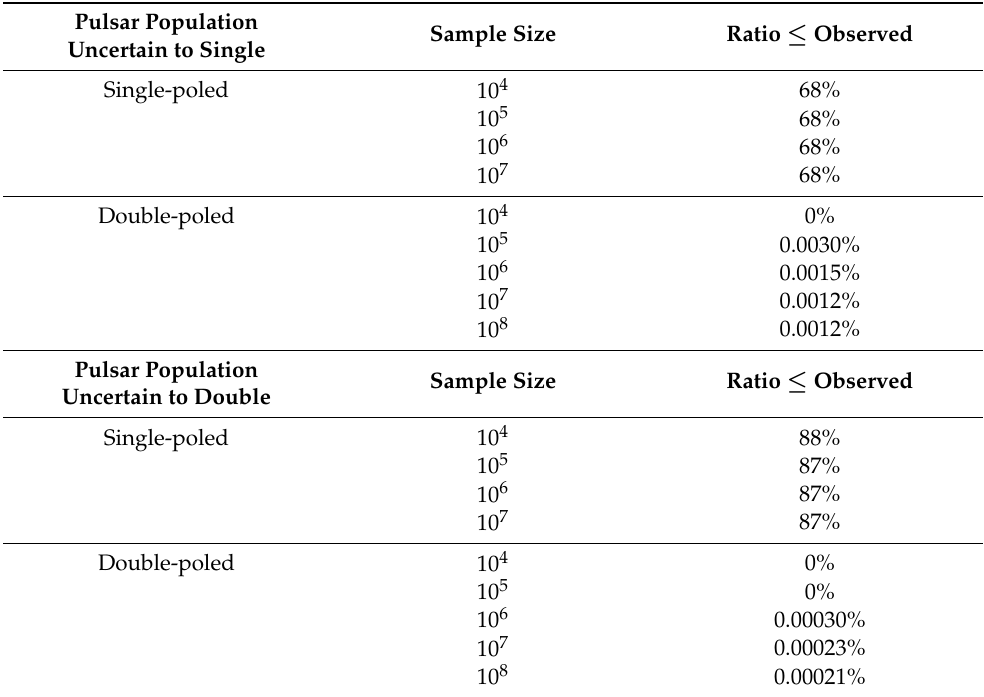
Table 3. The Monte Carlo simulation results for the penumbra values. The qualification “Uncertain to Single” means the circled red crosses of Figure 3 are grouped with the single-poled population. Sample size here refers to the number of Monte Carlo simulations carried